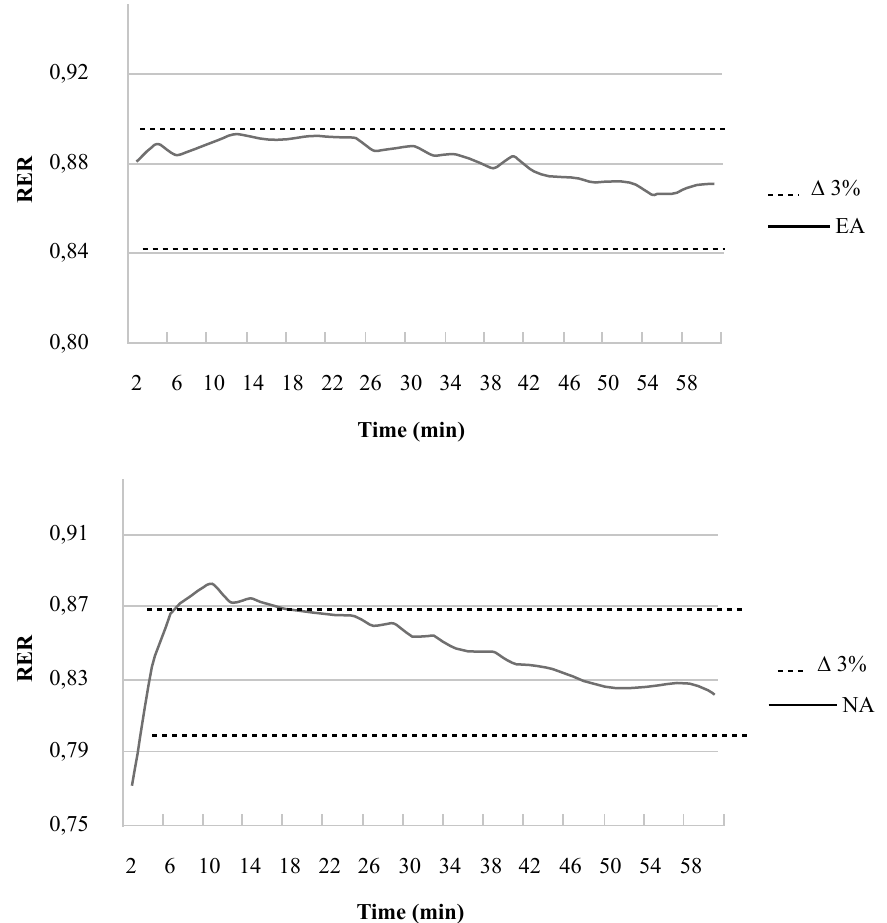
Figure 3− RER during 1 hour exercise at vVAT in the EA (p > 0.05) and NA (p < 0.05)